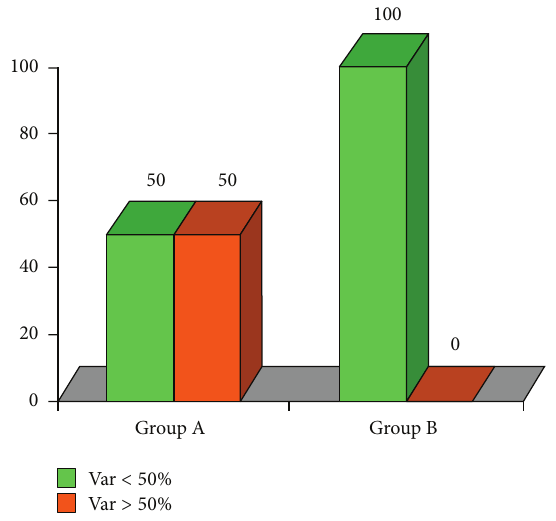
Figure 7: DLQI 50% variable in group A; 7 patients (50%) have had a reduction superior or equal to 50% after therapy with no patients in group